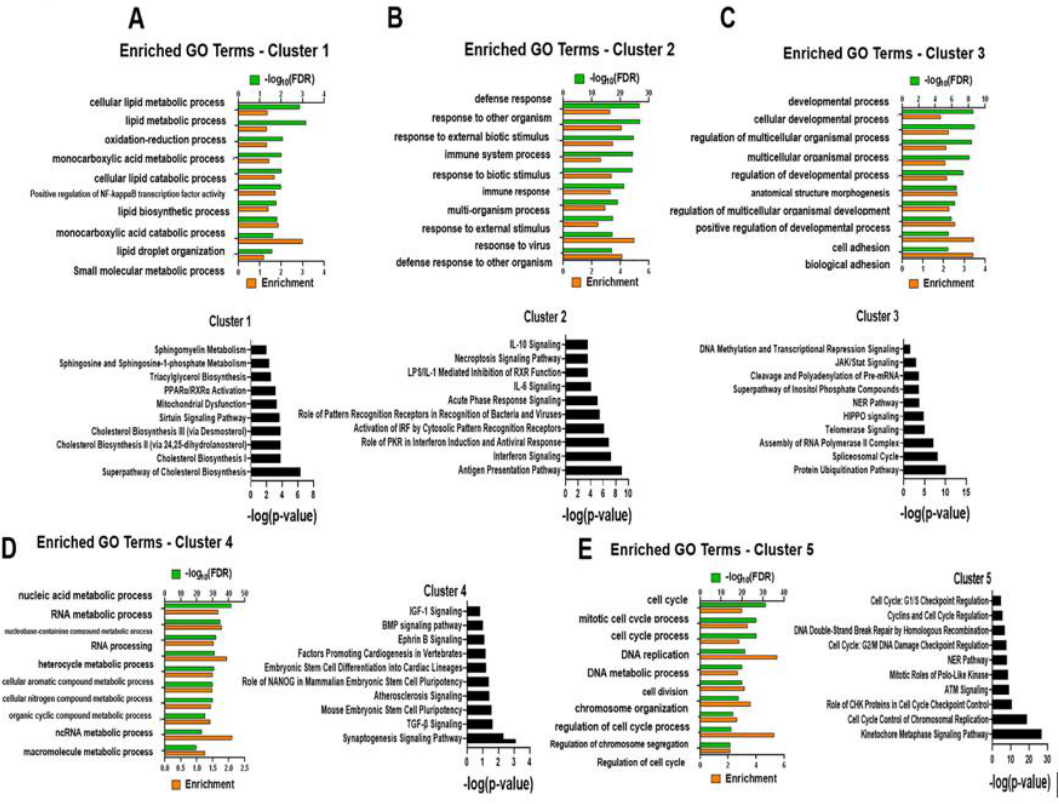
Figure 3. Functional analysis of each cluster. Top 10 GO terms generated from GO Biological Processes analysis for each cluster depicting − log 10 (FDR) and enrichment values and Ingenuity Pathway Analysis (IPA) together with Top 10 canonical pathways presented based on –log( p -value) for ( A ) Cluster 1, ( B ) Cluster 2, ( C ) Cluster 3, ( D ) Cluster 4, ( E ) Cluster